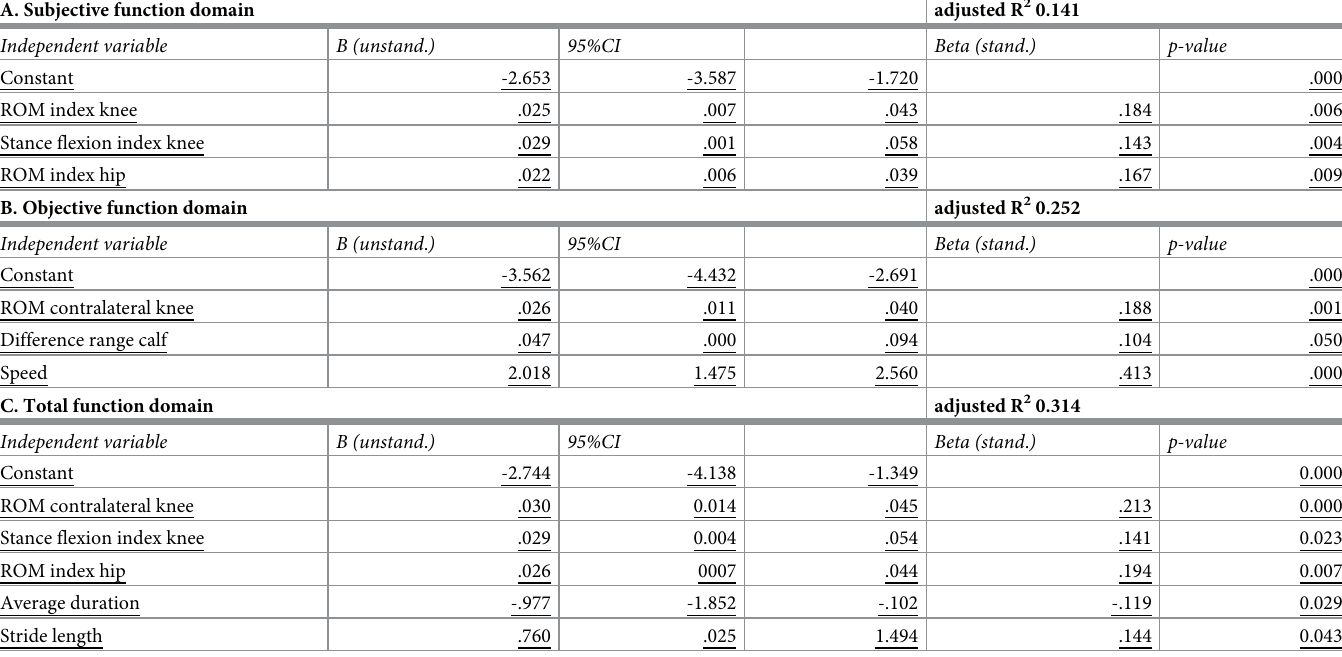
Table 2. Linear regression analysis for commonly used function domains.